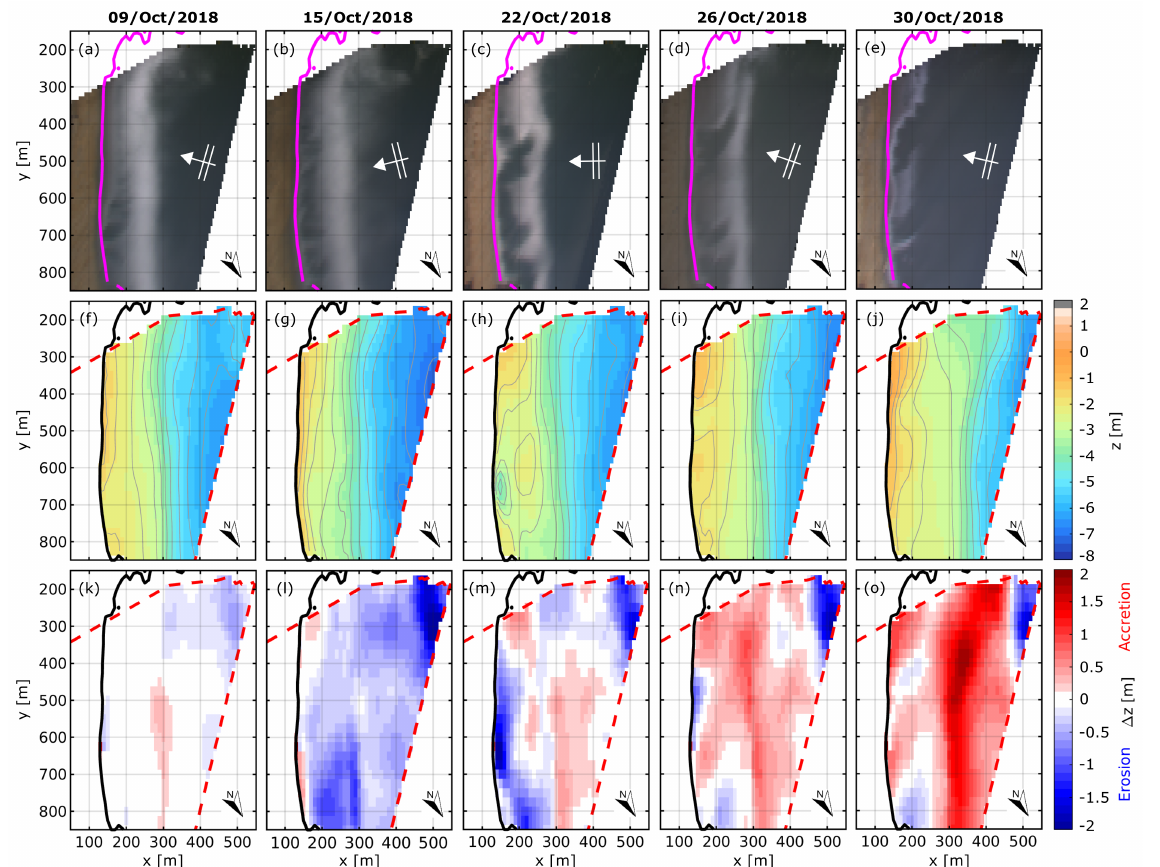
Figure 8. LPCA beach morphological evolution during October 2018 field experiment. ( a – e ) Time exposure (timex) image consisting of averaged pixel intensity over the record length of the stack. The magenta line indicates the zero-elevation contour relative to NGF-IGN69 and the white arrows indicate the angle of wave incidence θ p . ( f – j ) Kalman-filtered cBathy video-derived bathymetries. Ele- vation contours are spaced at 0.5 m intervals relative to NGF-IGN69. ( k – o ) Bathymetric change maps; difference between cBathy -derived bathymetries (panels: f – j ) and the cBathy -derived bathymetry from 8 October 2018 07:30:00 GMT, where red colors indicate sand accretion and blue colors sand erosion with respect to 8 October 2018 video-derived bathymetry. The red dashed lines indicate the limits of video-monitoring